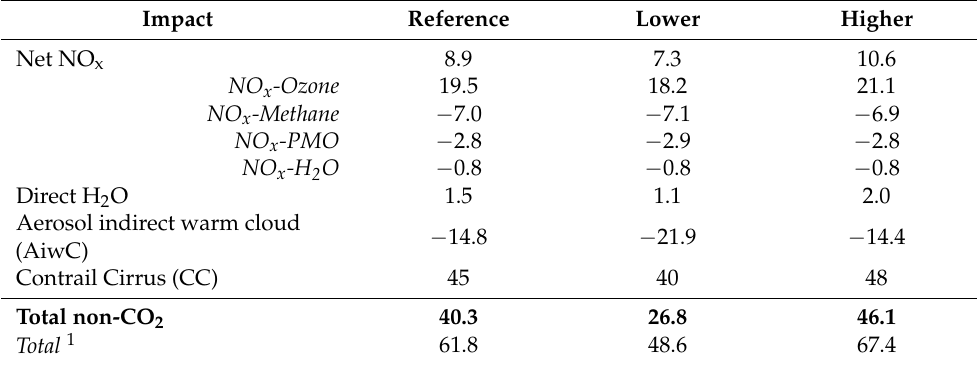
Table 3. Radiative forcings [mW/m 2 ] of individual effects for reference case and Flying Higher and Flying Lower scenarios, non-CO 2 presenting sum of all non-CO 2 effects, sensitivity